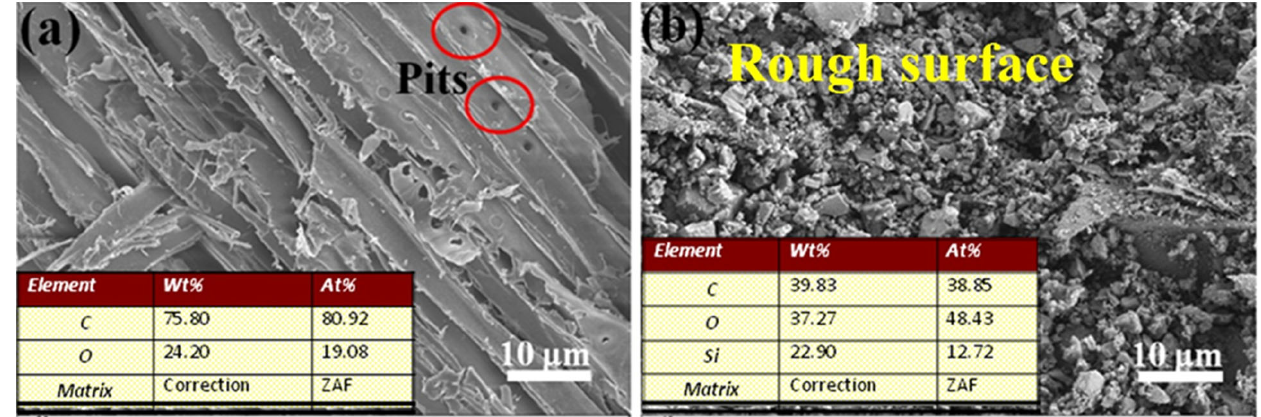
Figure 1. Surface morphology and EDS analysis of the wood substrate before ( a ) and after ( b ) the superhydrophobic